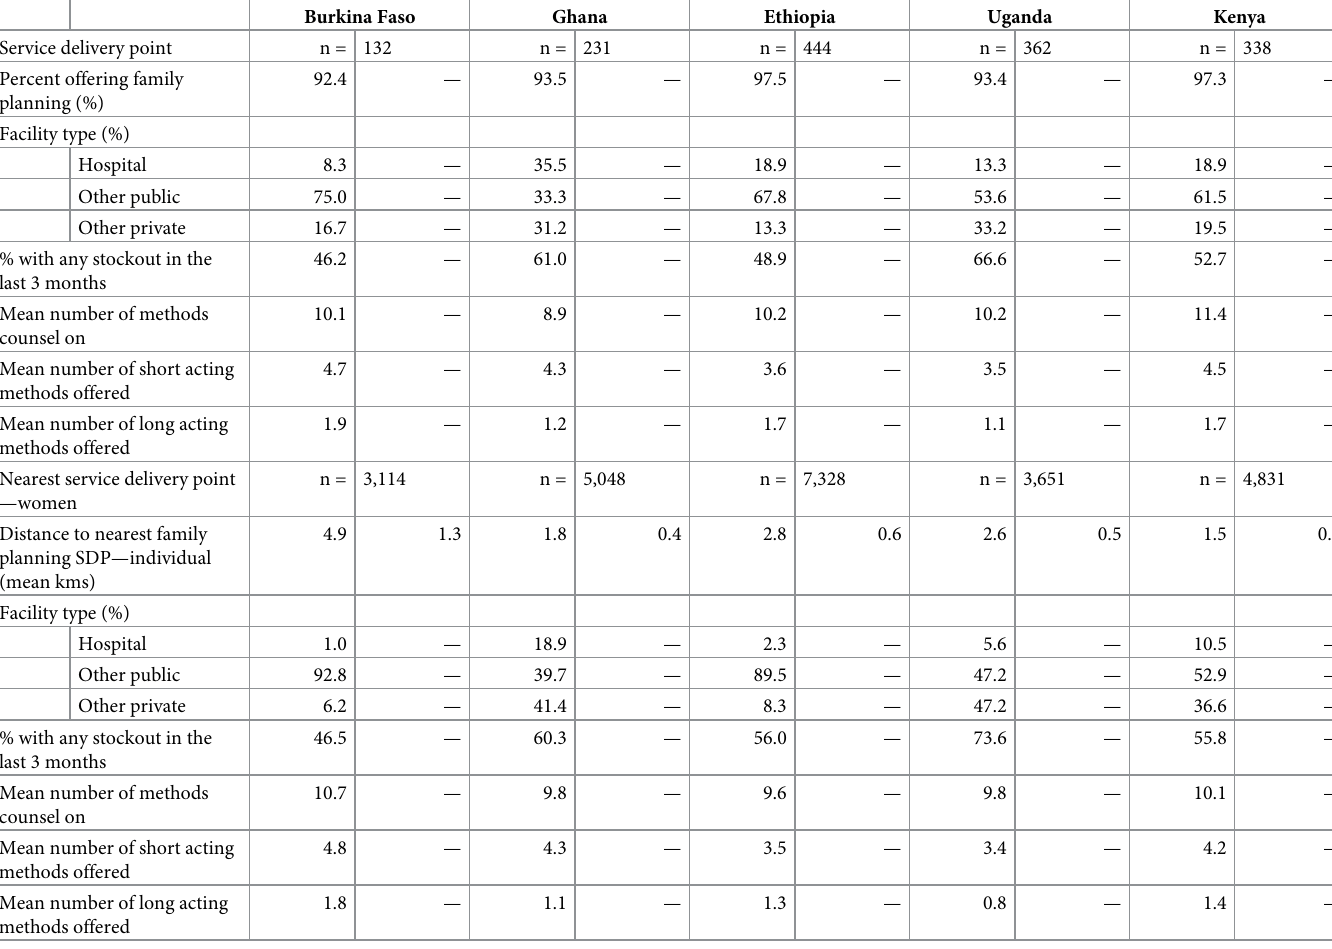
Table 2. Sample composition by variable type, country and survey year: Characteristics of total service delivery point sample and characteristics of nearest service delivery point to female sample.